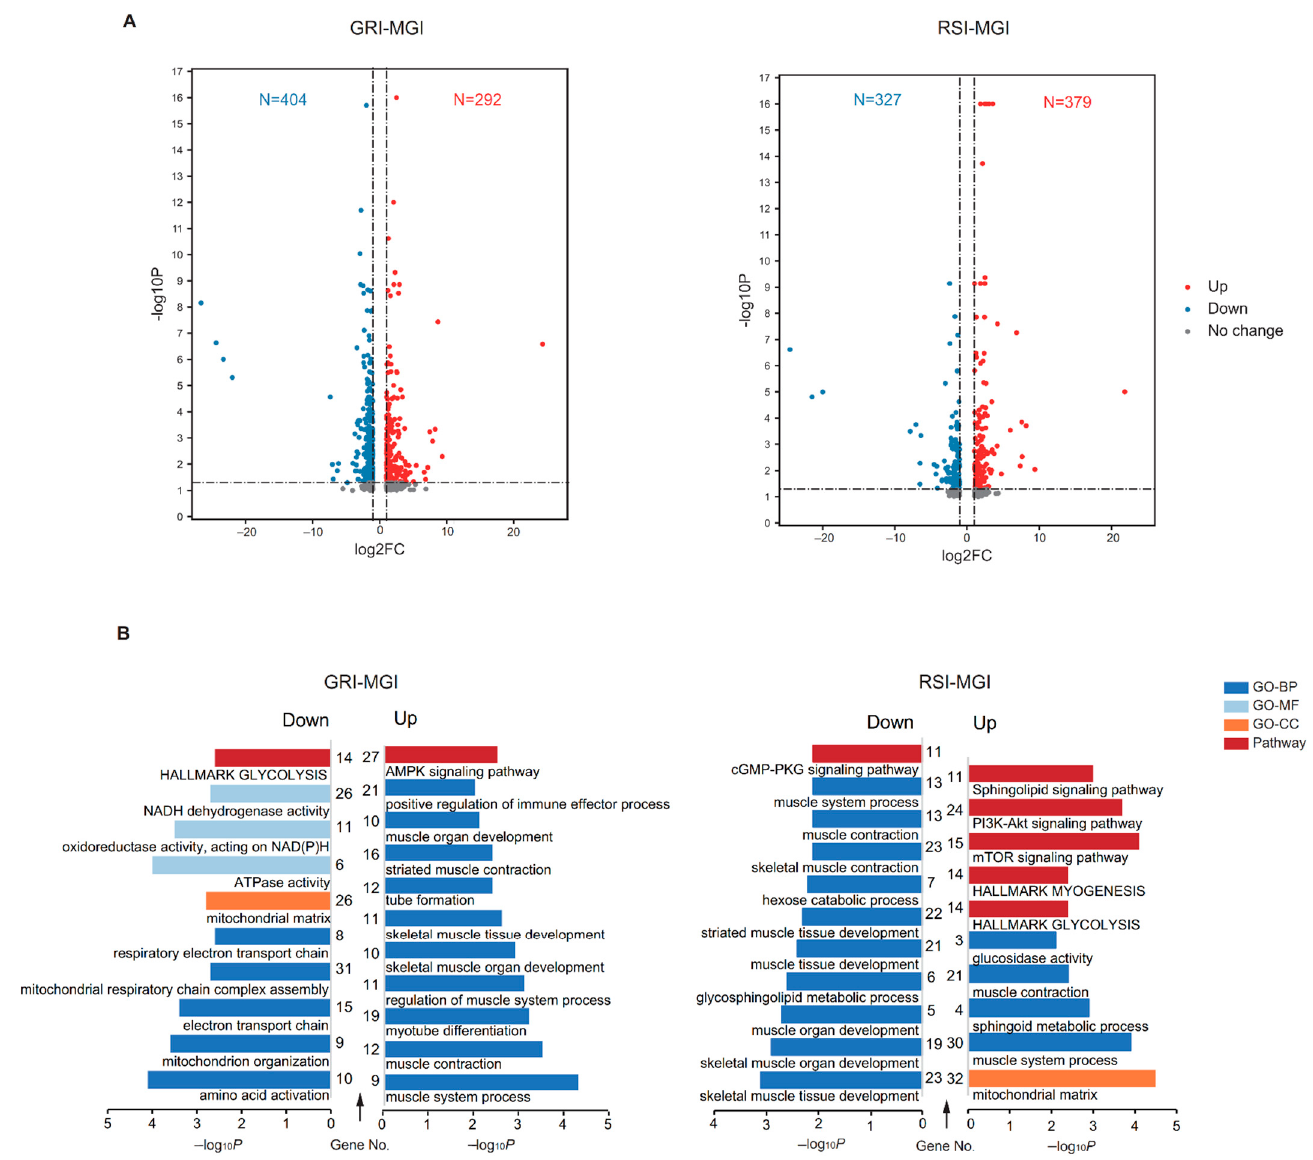
Figure 4. Enrichment analysis of differentially expressed lncRNAs in muscle development. ( a ) Volcano plot of DELs in GRI vs. MGI group (left) and RSI vs. MGI group (right). ( b ) Gene ontology and pathway analysis of cis target genes of DELs in GRI vs. MGI group (left) and RSI vs. MGI group (right). Abbreviations: MGI, the inflection point with the maximum growth rate; GRI, the inflection of the gradually increasing stage to the rapidly increasing stage; RSI, the inflection point of the rapidly increasing stage to the slowly increasing stage.